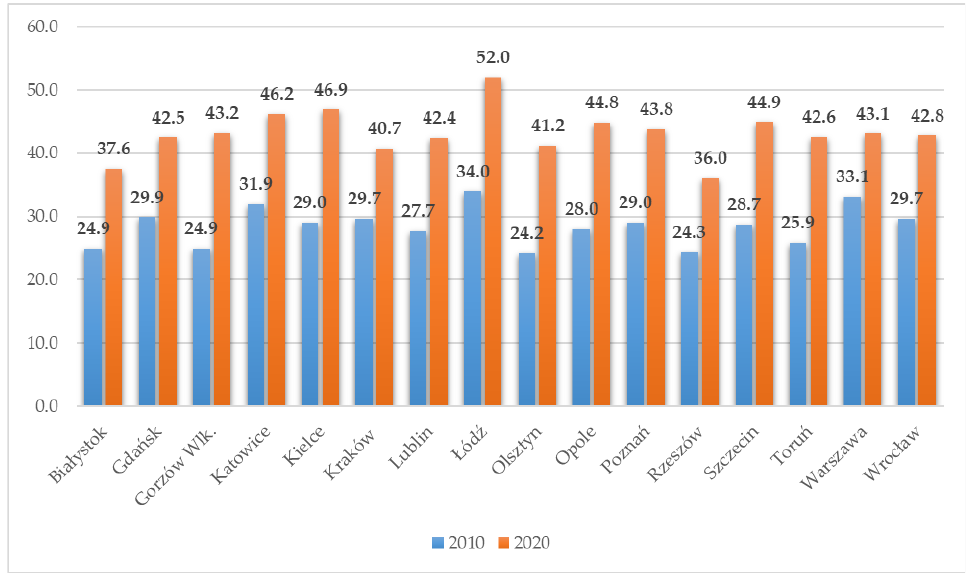
Figure 2. Population of post-working age per 100 people of working age in the surveyed Polish cities in 2010 and 2020.